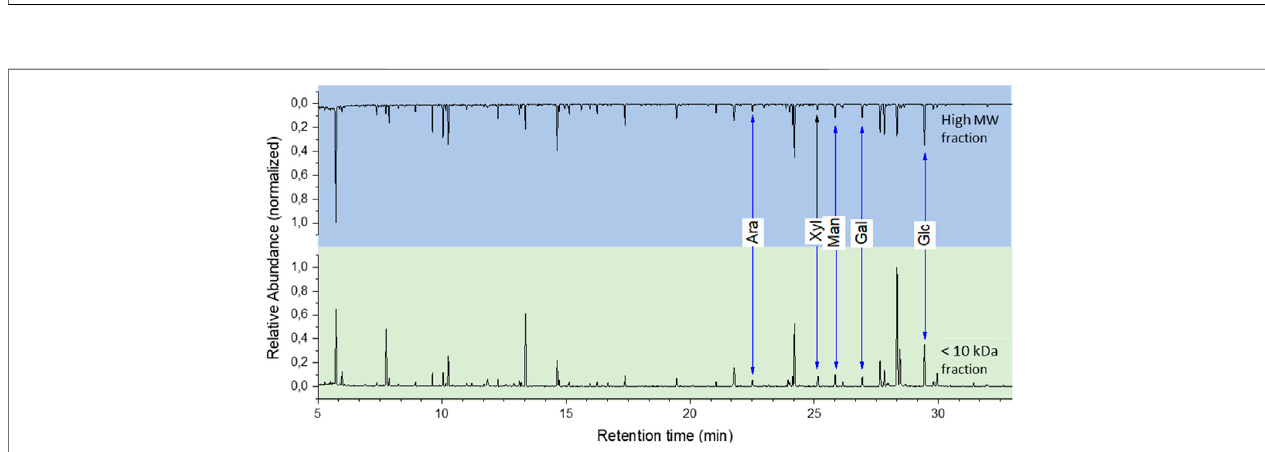
FIGURE 6 | GC-MS sugar analysis of the isolated